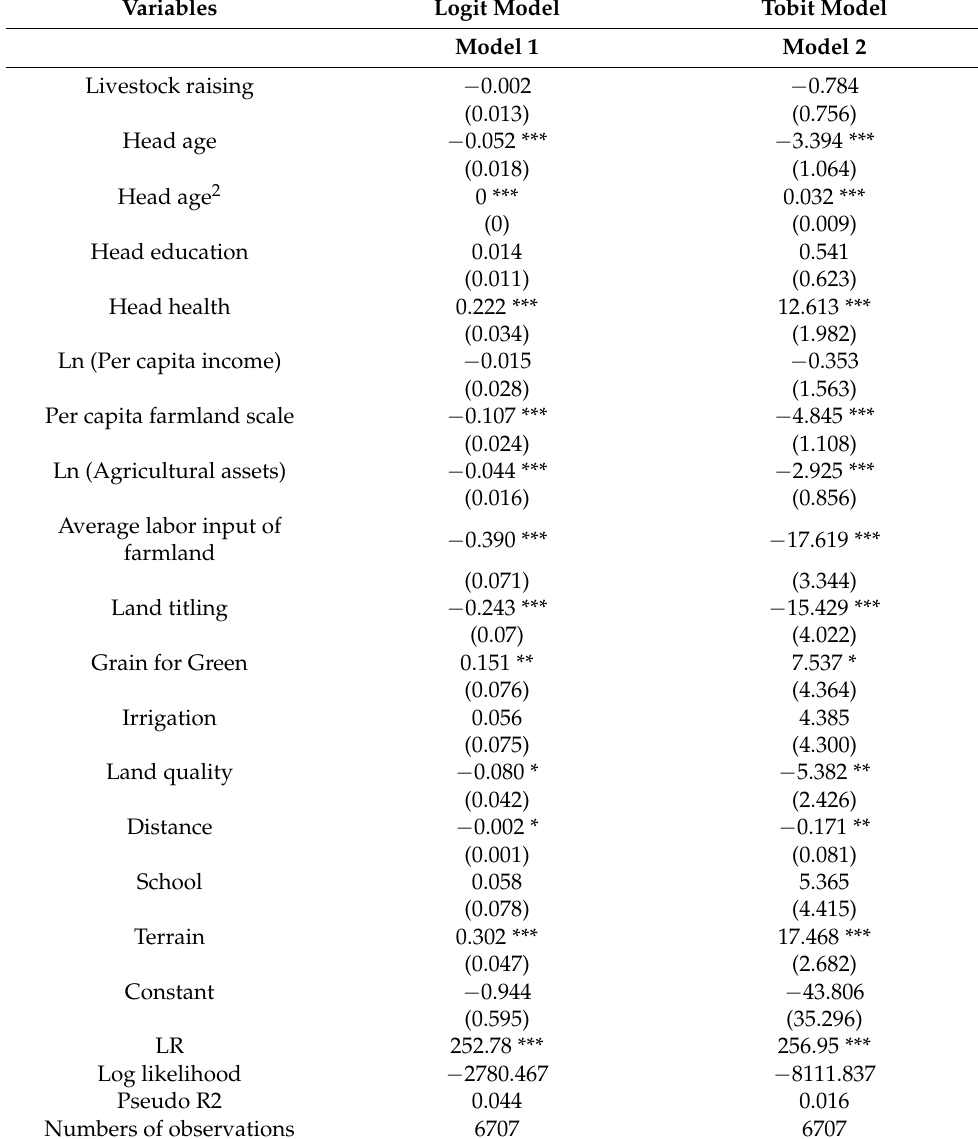
Table 2. Estimation results of the Logit and Tobit